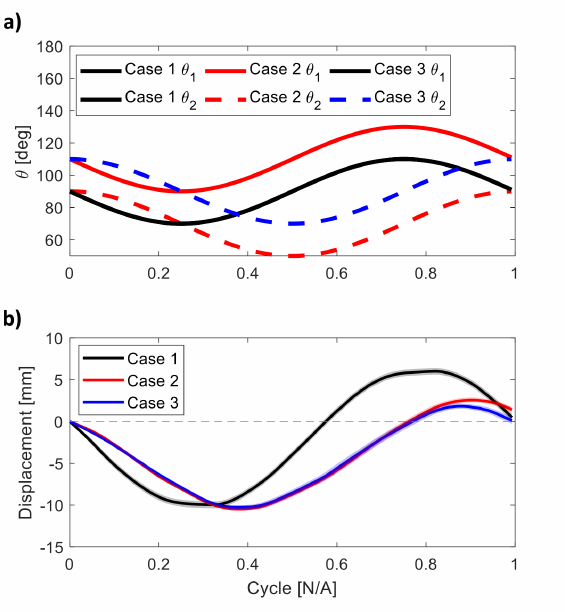
Figure 4. ( a ) Orientation angles of the two arms within one cycle for the three cases. ( b ) The mean displacement per cycle of the robot in the three experimental cases tested. The mean is obtained by taking the average over 14 cycles and the standard deviation is shown by the shaded region.